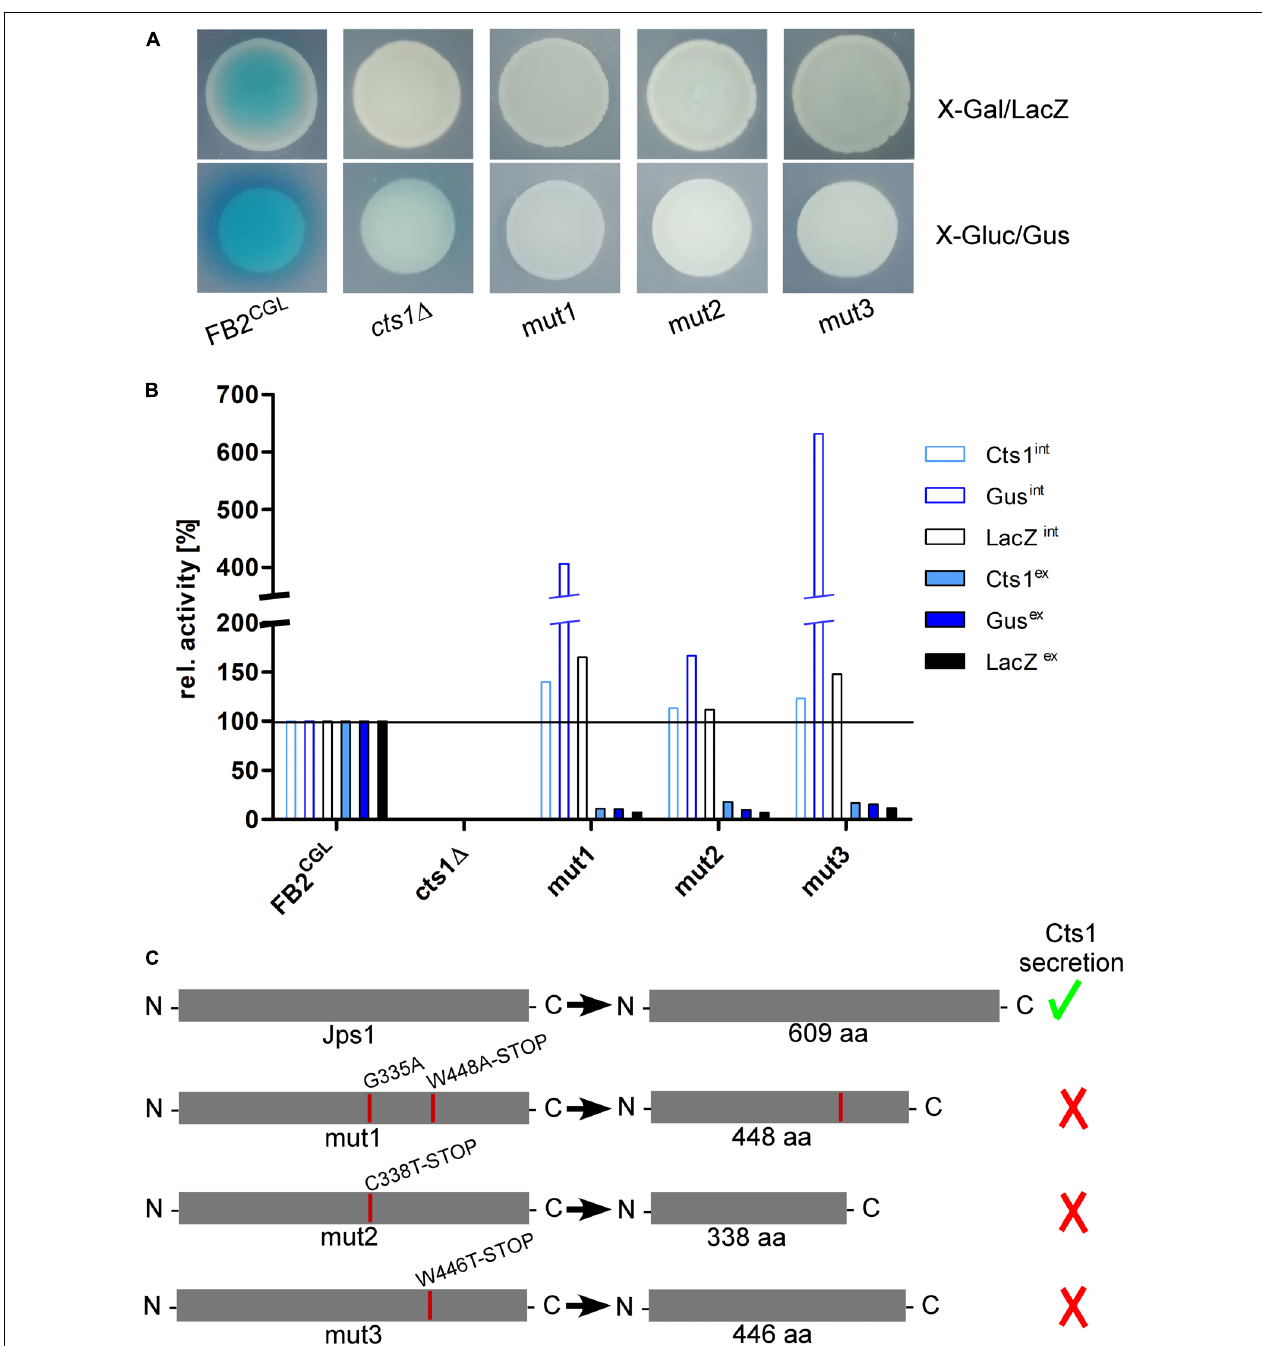
FIGURE 3 | The screen identifies the uncharacterized protein Jps1. (A) Plate assays of indicated strains for extracellular LacZ activity using X-Gal and extracellular Gus activity using X-Gluc. The assays are based on secretion of the reporters LacZ-Cts1 and Gus-Cts1 and the respective substrates are only converted, if the fusion protein is secreted. This leads to the formation of blue colonies (and blue halos in case of Gus) resulting from extracellular substrate conversion. Mutants FB2 CGL mut1, mut2 and mut3 were identified after UV mutagenesis of strain FB2 CGL on screening plates (white colonies on both X-Gluc and X-Gal) and show the expected reduced extracellular activities indicating deficiency in Cts1 secretion. (B) Quantitative liquid assays detecting intracellular (int, filled columns) and extracellular (ex, open columns) Gus, LacZ and Cts1 reporter activity. Screening strain FB2 CGL and a cts1 deletion mutant (AB33 cts1 (cid:49) , 15) were used as positive and negative controls, respectively. Activities obtained for FB2 CGL were set to 100% to allow for a direct comparison of all strains. The assay was conducted thrice with similar results and a representative replicate is shown. (C) In all three identified mutants, base exchanges in gene umag_03776 , now termed jps1 , were identified. At the aa level, mutations result in the introduction of premature stop codons leading to the production of truncated proteins in all three mutants. Mut1 carries an additional aa exchange at position 335. Mutations identified in FB2 CGL mut1-3 are indicated with red lines in the schematic representation of the protein. The size of native Jps1 is 609